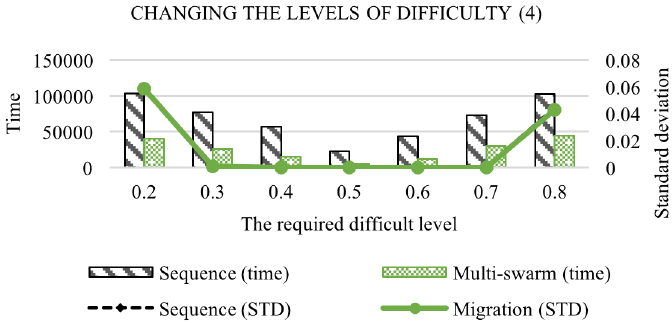
Fig. 3. Changing the levels of di±culty with the parameters in Table 3, column